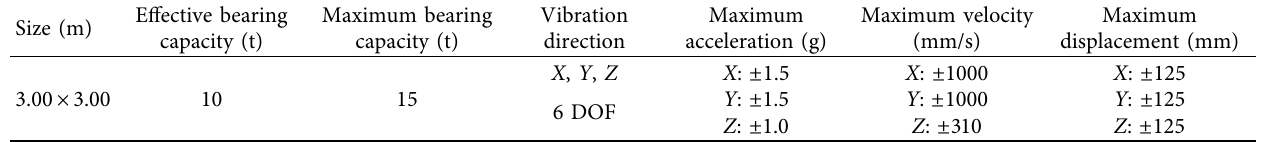
Table 1: Specific parameters of shaking table.